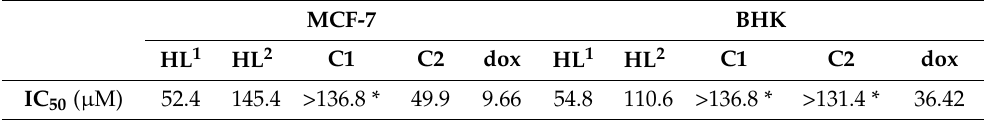
Table 3. IC 50 values ( µ M) of MCF-7 cancer and BHK normal cells exposed to compounds HL 1 , HL 2 , C1 , C2 and doxorubicin